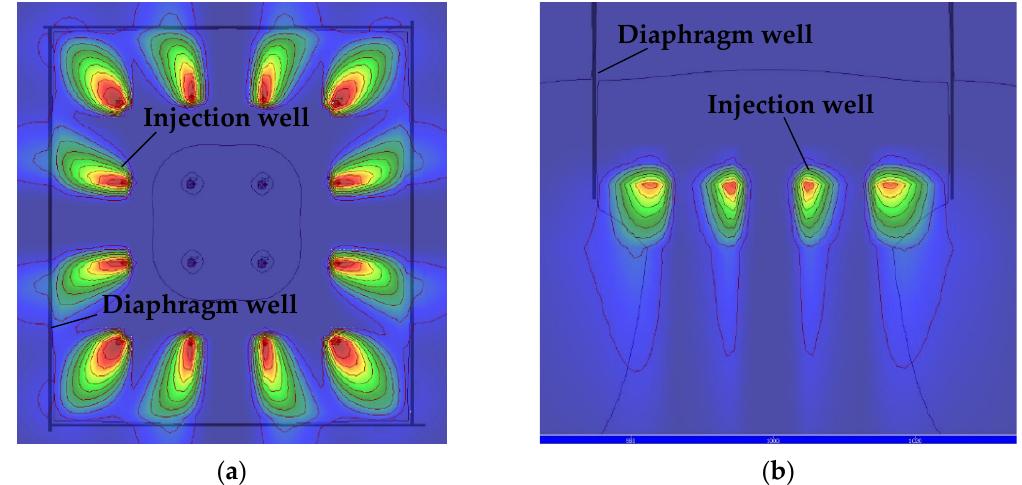
Figure 12. Migration of S. pasteurii after 4 days: ( a ) Horizontal; ( b ) Vertical.